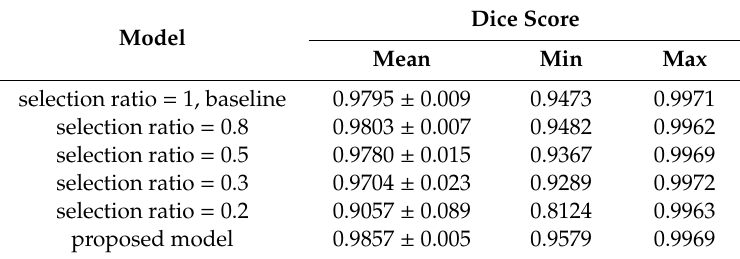
Table A5. Spleen segmentation results on test dataset based on di ff erent selection ratio using U-Net